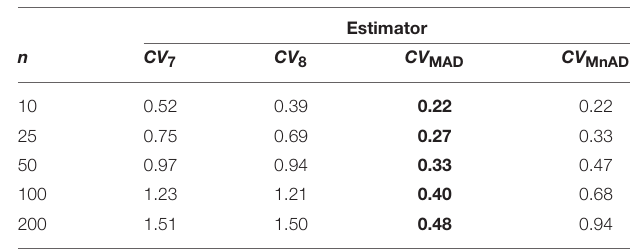
TABLE 6 | Median values of log 10 ( γ ) accuracy metric across θ produced for each estimator and sample sizes under Poisson distribution.